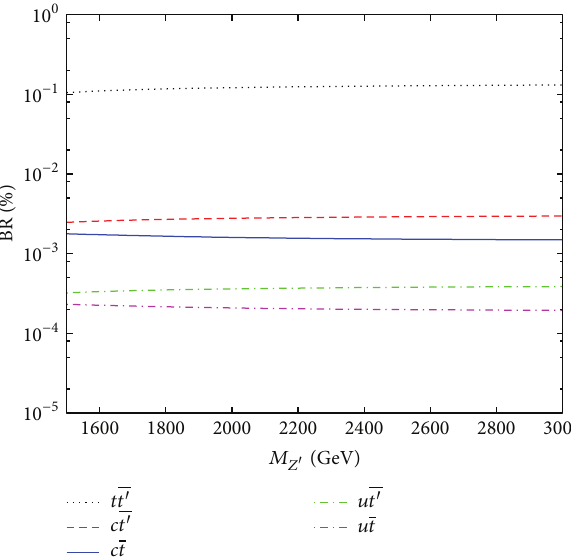
Figure 9: Branching ratios (%) depending on the mass of the 𝑍 󸀠